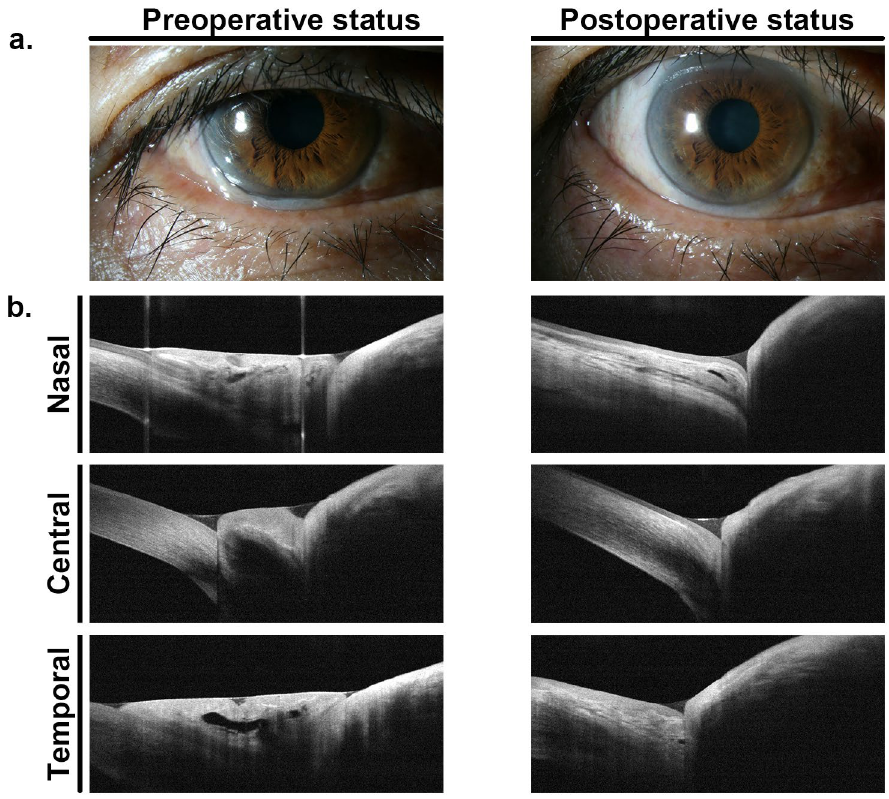
Figure 3. Representative photographs of the surgical effect of high frequency radiowave electrosurgery for conjunctivochalasis. ( a ). At one month after high-frequency radiowave electrosurgery for conjunctivochalasis (CCh), complete elimination of CCh was confirmed using slit-lamp biomicroscopy. ( b ) Anterior segment optical computed tomography also identified recovery of tear reservoirs at the nasal, central, and temporal regions of the lower lid margin, as well as removal of redundant conjunctival tissue.